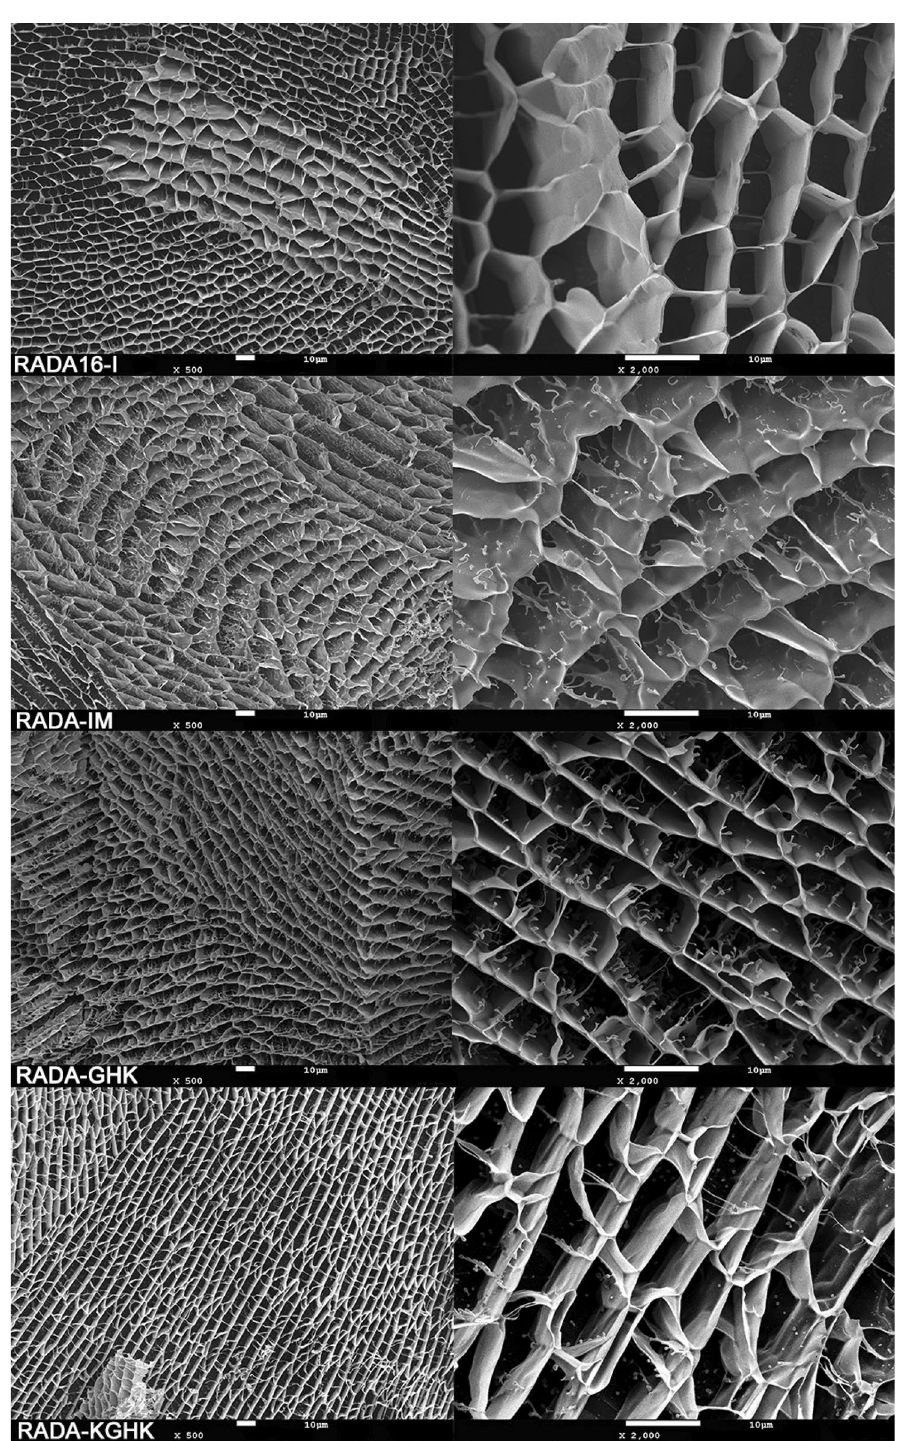
Figure 7. CryoSEM images of RADA peptides. The photographs represent a surface view of the